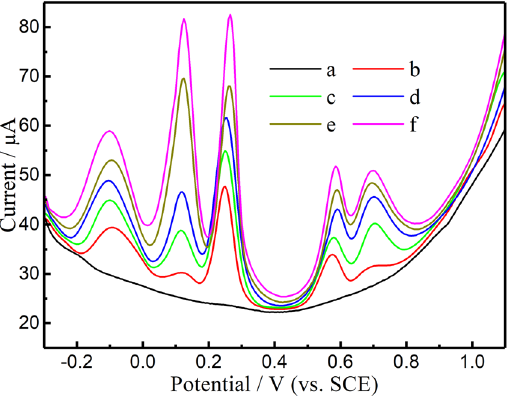
Figure 6. DPV curves of the graphene/Ta wire electrode in PBS the (a) absence and (b) presence of human serum and in (c–f) human serum containing additional AA, DA, UA, Trp, and − NO